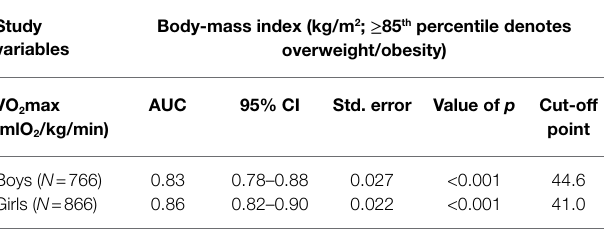
TABLE 2 | Receiver operating curve cut-offs for cardiorespiratory fitness (CRF) to predict overweight/obesity for different anthropometric indices, stratified by sex. Study